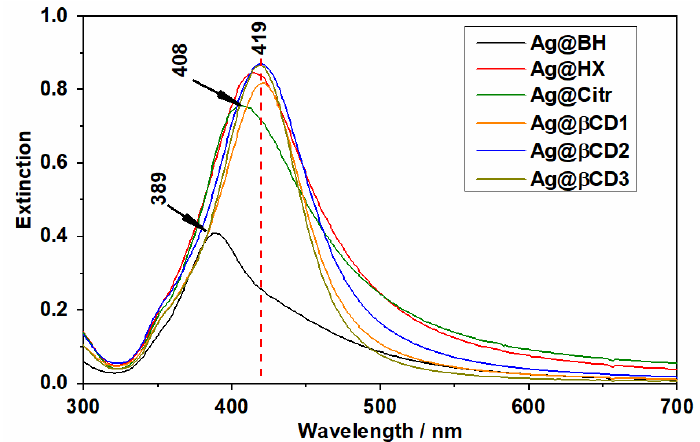
ff erent synthesized Ag nanoparticles